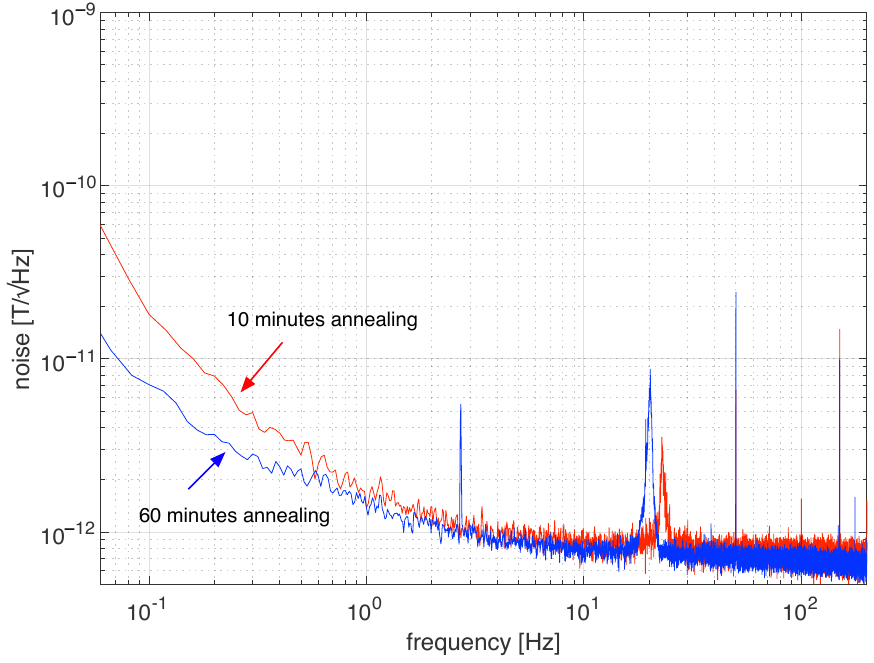
Figure 9. Noise spectra of two orthogonal fluxgates based on a single wire with ( Co 0.942 Fe 0.058 ) 72.5 Si 12.5 B 15 composition annealed for 10 min and 60